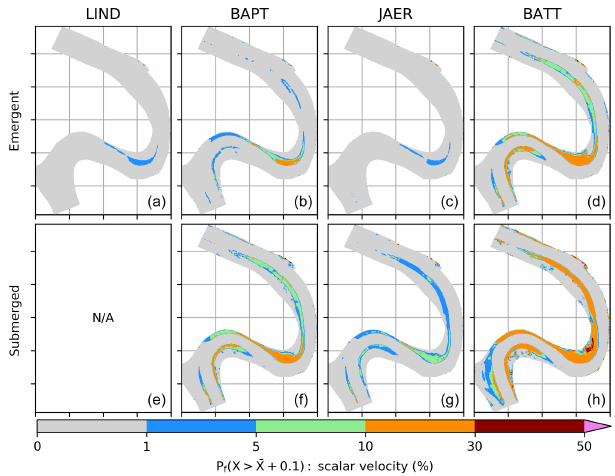
Figure 6. Risk analysis of flow velocity for threshold u + 0 . 1ms − 1 under emergent (a–d) and submerged (e–h)